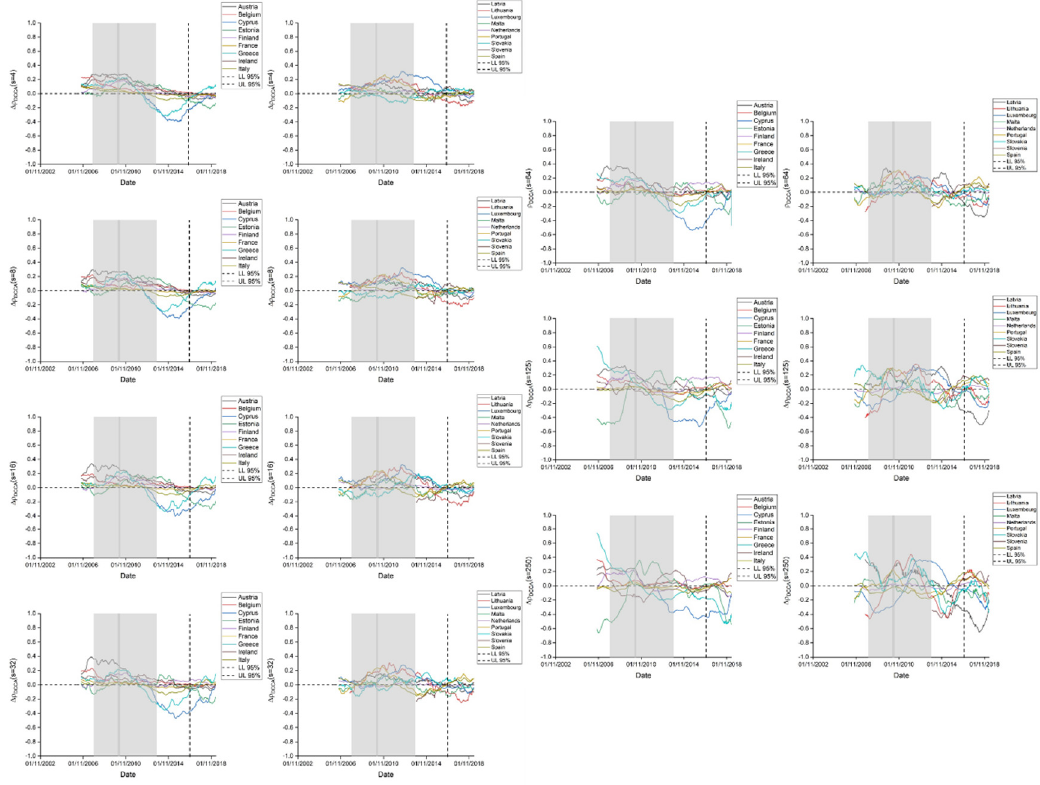
Figure A5. Evolution of the ∆ ρ DCCA between Eurozone stock markets and Germany for time scales of 4, 8, 16, 32, 64, 125, and 250 days, considering that ∆ ρ DCCA ( 1 ) = ρ DCCA ( 1001 ) − ρ DCCA ( 1 ) . LL and UL are, respectively, the lower and upper limits of the confidence interval. Shaded areas represent the global financial crisis and the Eurozone debt crisis. The vertical dashed line refers to the moment of the Brexit referendum.